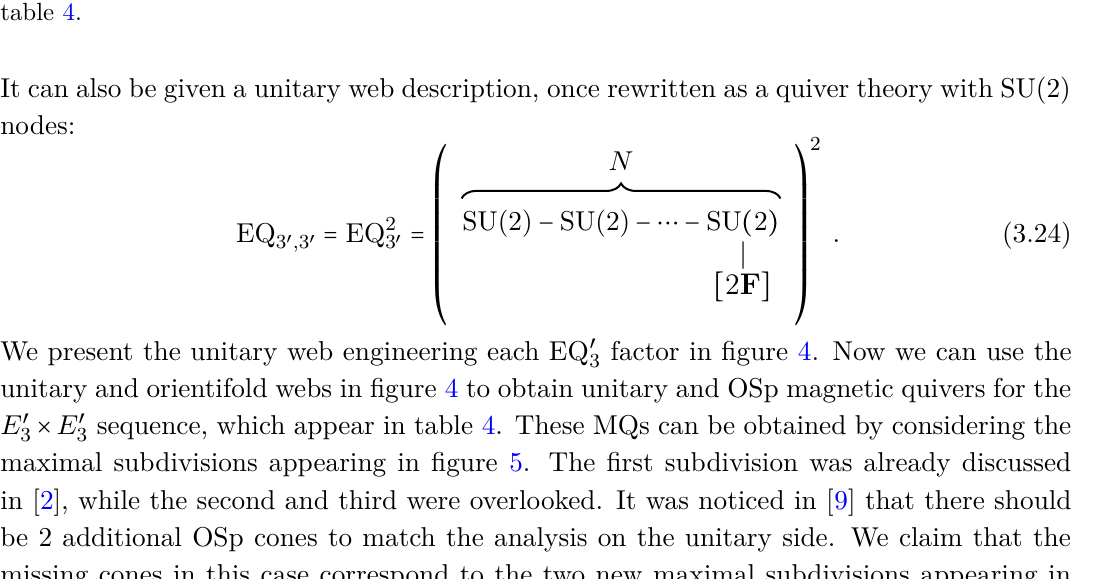
Figure 5. Maximal subdivisions of the Higgs branch of EQ 3 ′ , 3 ′ at the superconformal limit. The subweb coloured in red is frozen and contributes only as flavour nodes to the magnetic quivers in table